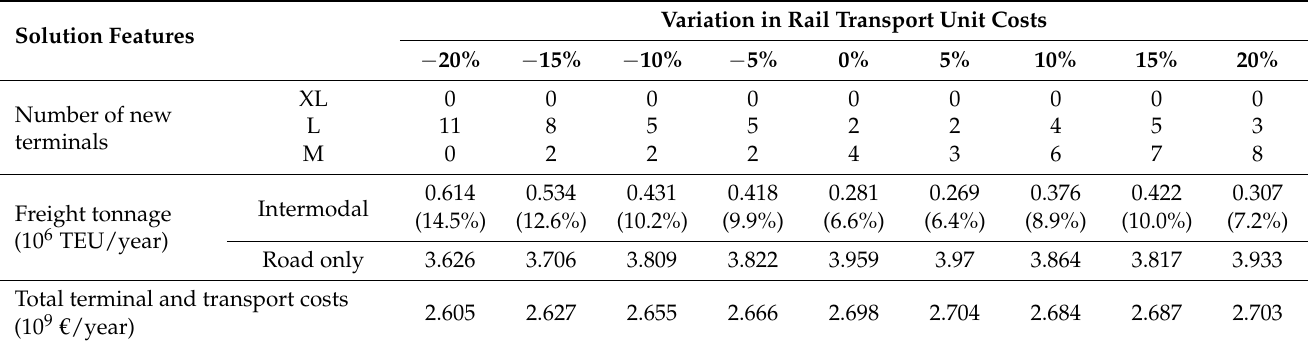
Table 9. Sensitivity of optimal solutions to variations in rail transport unit costs in a decentralized management context. Solution